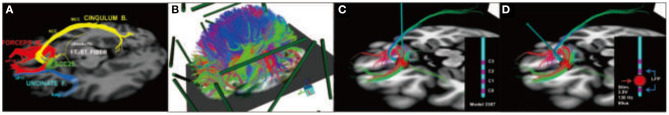
Prospective targeting of these four white matter bundles can be performed reliably in individual patients, and use of this method improves long-term outcomes. (A) Four-bundle white matter “blueprint”: cingulum (yellow), uncinate fasciculus (blue), forceps minor (red), frontal-striatal (white). (B) Whole-brain tractography loaded in patient-specific stereotactic frame space using StimVision. (C) Visualizing tracts passing through the volume of tissue activated (VTA) to define optimal target location that best visually matched the “blueprint.” (D) Finalization of lead trajectory with the neurosurgeon to avoid cerebral vasculature and choosing the point of entry.